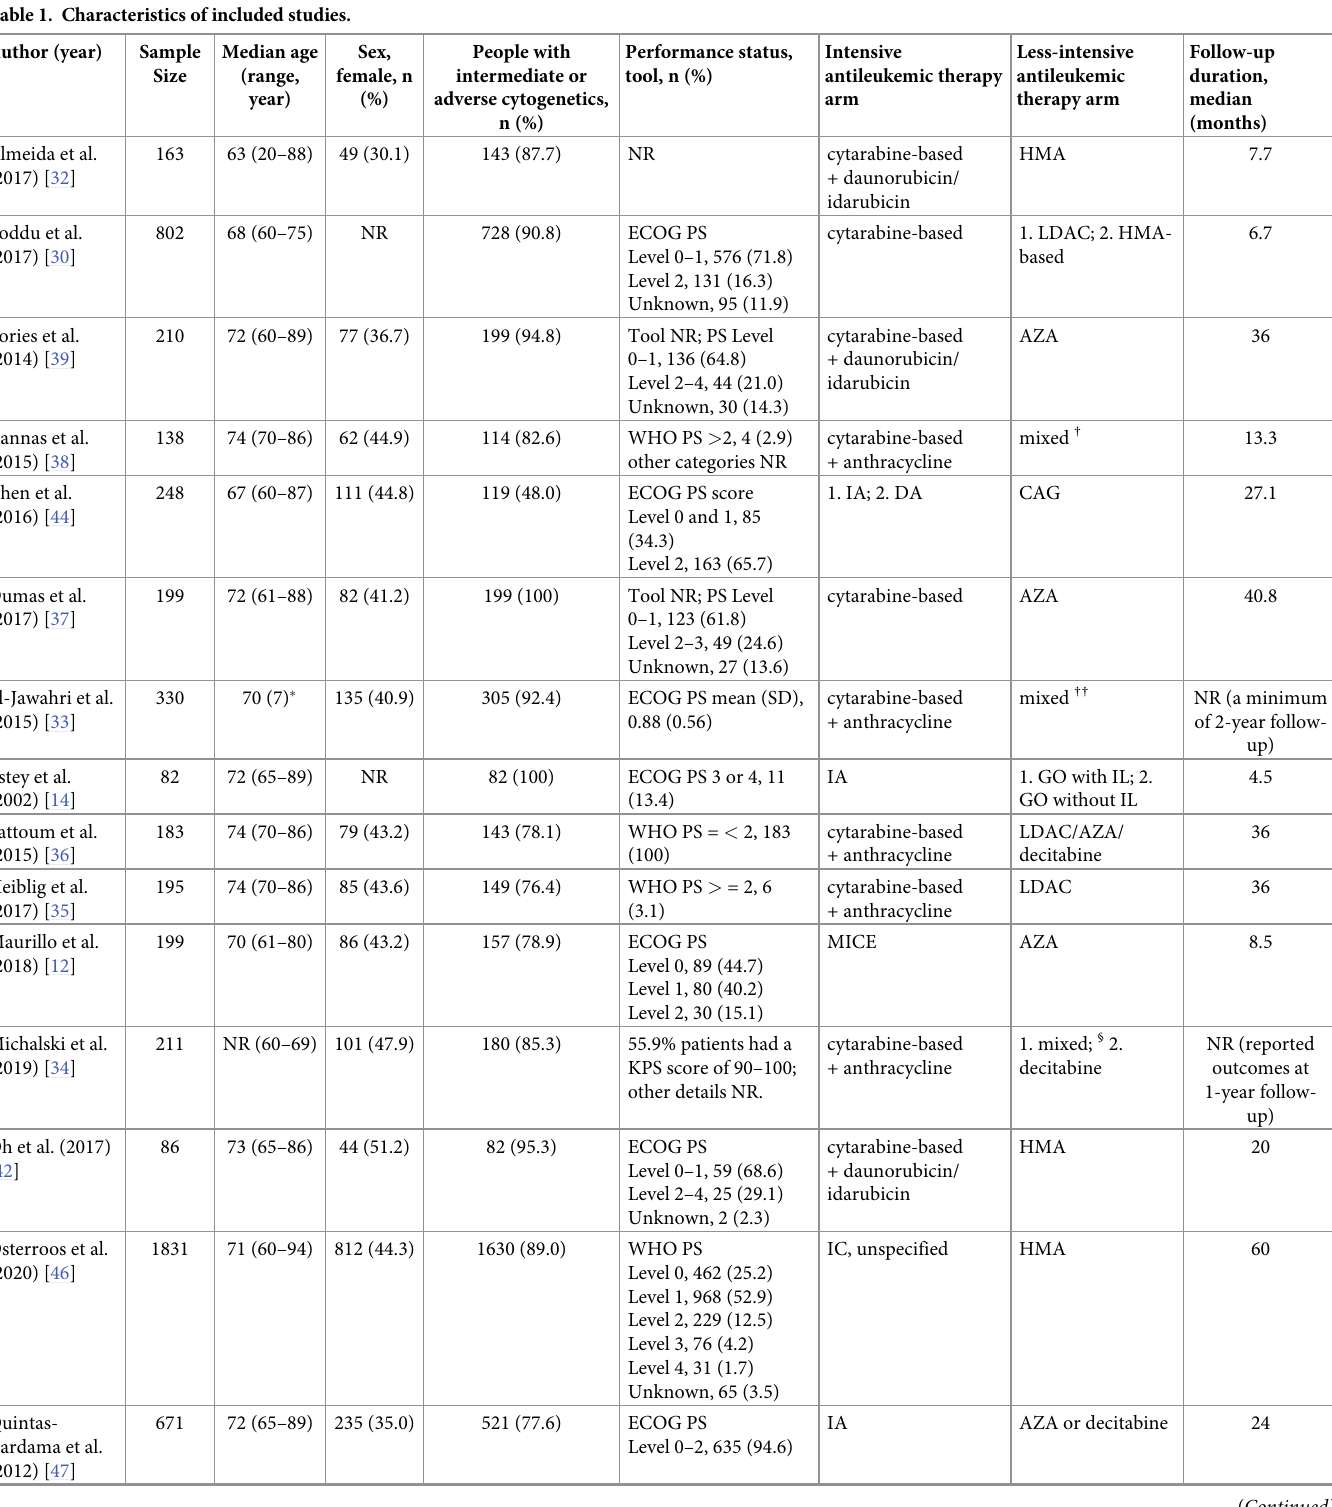
Table 1. Characteristics of included